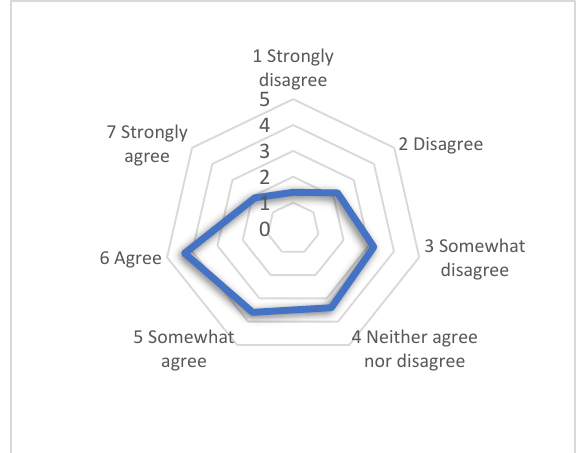
Figure 17. Engagement assessment.